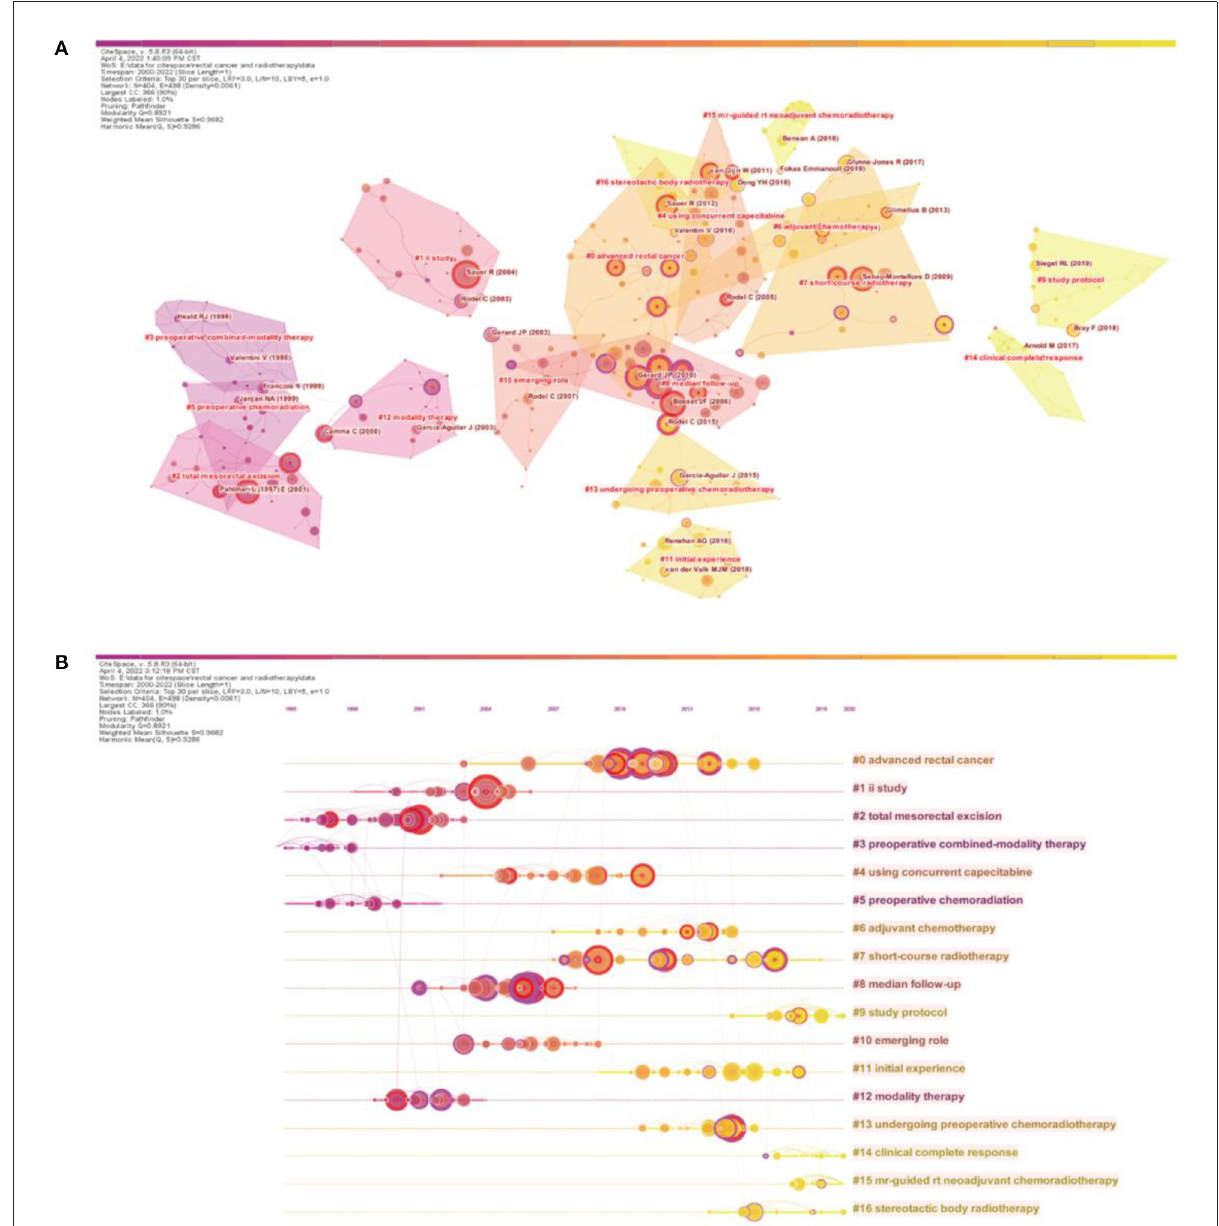
FIGURE6 Analysis of the cited articles. (A) Knowledge map of the cited literature (Timespan: 2000–2022; Slice Length: 1; Selection Criteria: Top30 per slice; Network: N = 404, E = 498; Density: 0.0061; Largest CC:366; Nodes Labeled:1.0%; Pruning: Pathfinder; Modularity Q:0.8921; Weighted Mean Silhouette S:0.9682). (B) Time axis map of the cited literature (Timespan: 2000–2022; Slice Length: 1; Selection Criteria: Top30 per slice; Network: N = 404, E = 498; Density: 0.0061; Largest CC:366; Nodes Labeled:1.0%; Pruning: Pathfinder; Modularity Q:0.8921; Weighted Mean Silhouette